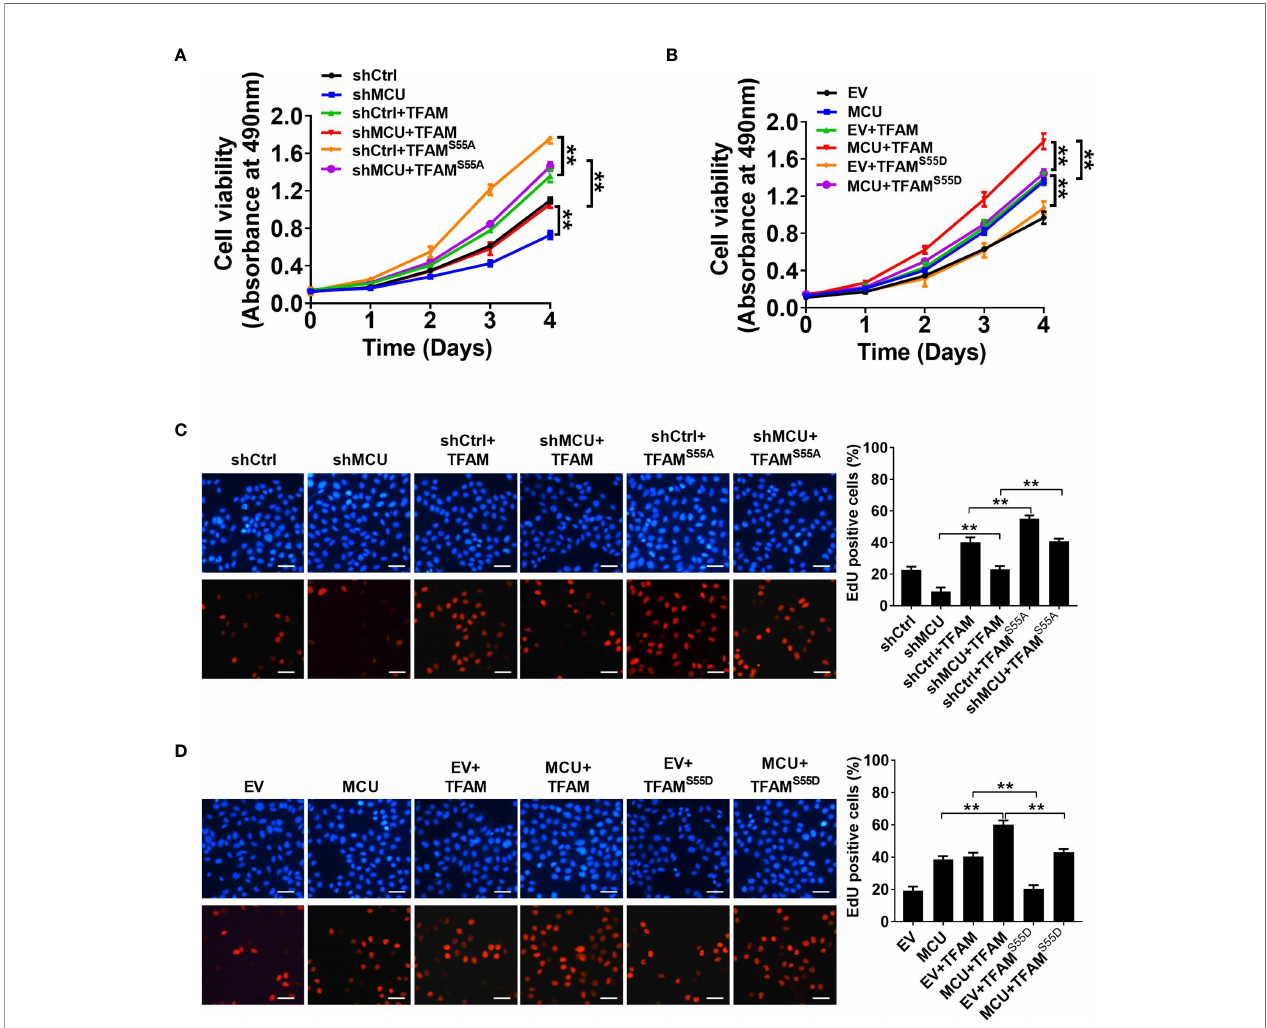
FIGURE 5 | Decreased phosphorylation of TFAM is involved in mitochondrial Ca2+-mediated CRC growth in vitro . (A, B) MTS assay for cell viability and (C, D) EdU incorporation assays for cell proliferation in LS174T cells with treatments as indicated (scale bar, 20 m m). **P <